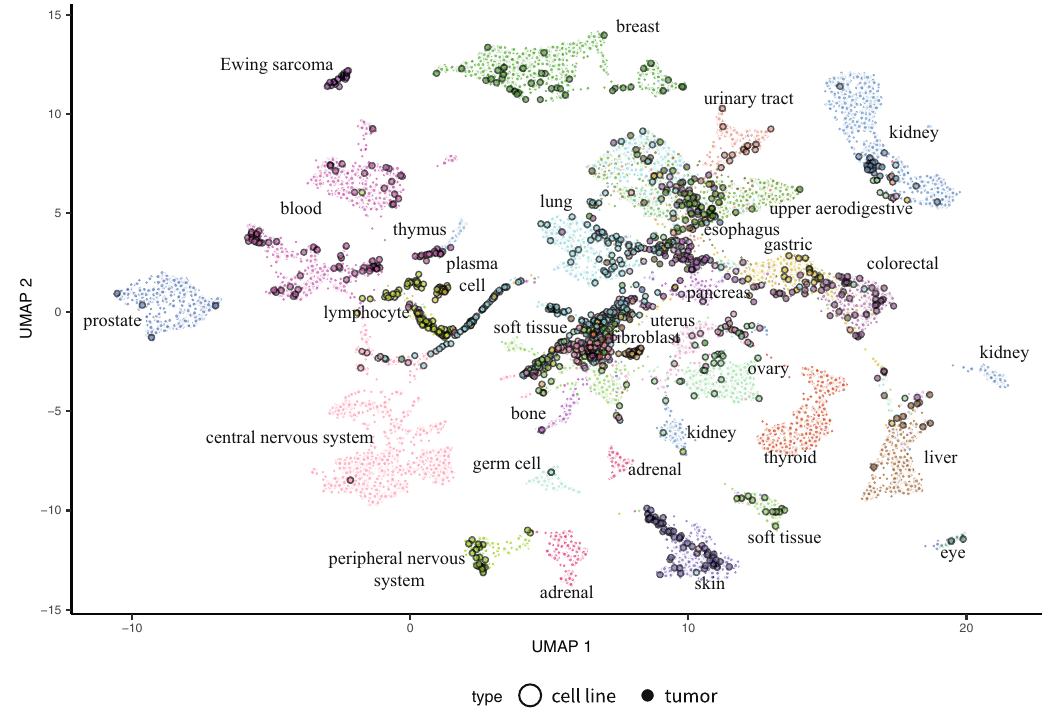
Fig. 2 Celligner alignment of tumor and cell line samples. UMAP 2D projection of Celligner- aligned tumor and cell line expression data colored by annotated cancer lineage. The alignment includes 12,236 tumor samples and 1,249 cell lines, across 37 cancer